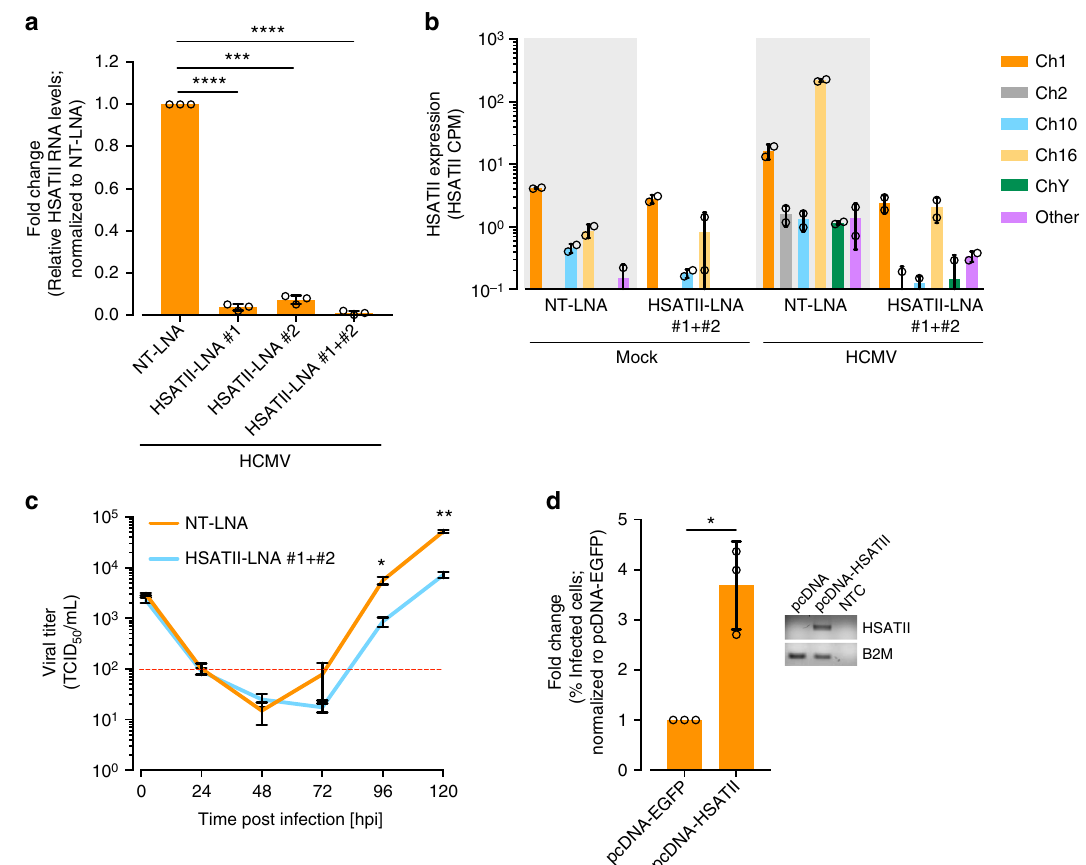
Fig. 3 HSATII RNA is important for ef fi cient HCMV yield. RNA samples were collected at 24 hpi from HFFs transfected with NT-LNA or HSATII-LNAs 24 h before HCMV (TB40/E-GFP) infection at 1 TCID 50 /cell. a RT-qPCR was performed using HSATII-speci fi c primers. GAPDH was used as an internal control. Data are presented as a fold change mean ± SD. n = 3. *** P < 0.001, **** P < 0.0001 by the unpaired, two-tailed t -test with Welch ’ s correction. Open circles represent single data points. b RNA-seq analysis performed. Only unique HSATII reads were used to calculate its expression. HSATII expression in terms of CPM was computed and normalized across samples. n = 2. Open circles represent single data points. c Media samples were collected at indicated times from HFFs transfected with NT-LNA or HSATII-LNAs 24 h before HCMV (TB40/E-GFP) infection at 1 TCID 50 /cell. TCID50 ml − 1 values were determined. n = 3. * P < 0.05, ** P < 0.01 by the unpaired, two-tailed t -test. d Media samples were collected at 96 hpi from HFFs transfected with pcDNA or pcDNA- HSATII 48 h before HCMV (TB40/E-GFP) infection at 1 TCID 50 /cell. % of infected cells was calculated based on a number of IE1-positive cells in a reporter plate. Data are presented as a fold change mean ± SD. n = 3. * P < 0.05 by the unpaired, two-tailed t -test with Welch ’ s correction. Open circles represent single data points. Inside panel: RNA samples were collected from pcDNA or pcDNA-HSATII-transfected and HCMV-infected HFFs. HSATII-pcDNA primer set was used in RT-PCR analysis. B2M was used as an internal control. NTC non-template control